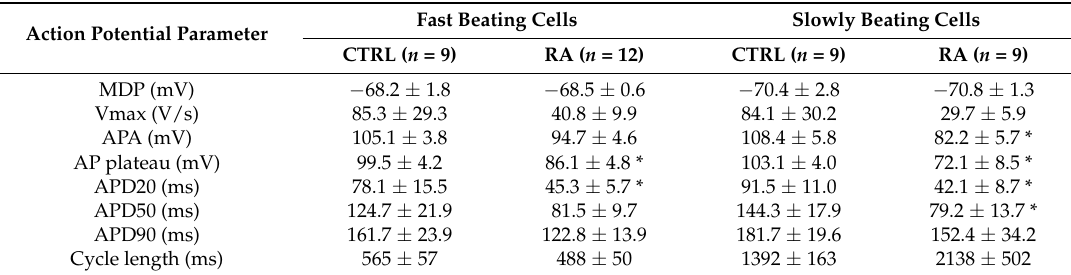
Data are mean ± SEM. CTRL: control cells; RA: retinoic acid-treated cells; n : number of cells; MDP: maximum diastolic potential; V max : maximum upstroke velocity; APA: action potential amplitude; AP plateau: AP plateau amplitude; APD 20 , APD 50 , and APD 90 : action potential duration at 20%, 50%, and 90% repolarisation, respectively. * p < 0.05 RA vs.